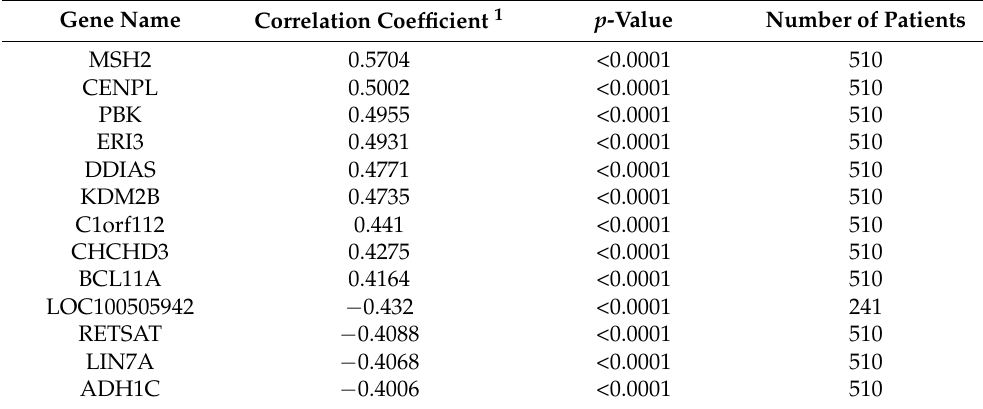
Table 2. Shows genes that correlate positively and negatively with TUBB in ER α -negative breast cancer